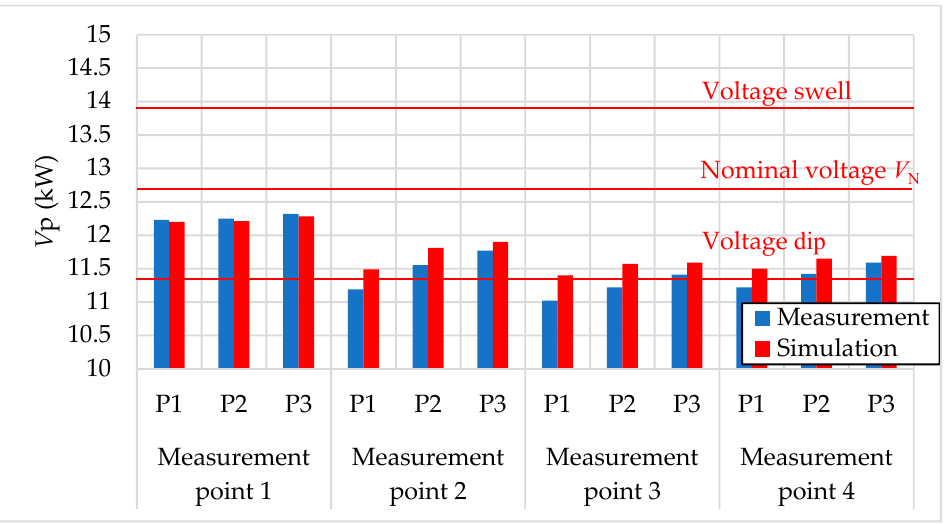
Figure 32. Voltage levels at the measurement points in the distribution grid.